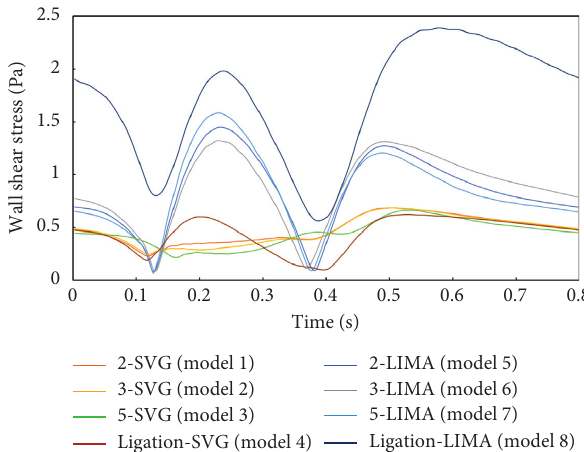
Figure 4: The WSS depending on times of the bypass grafts (SVG and LIMA) in a cardiac cycle.